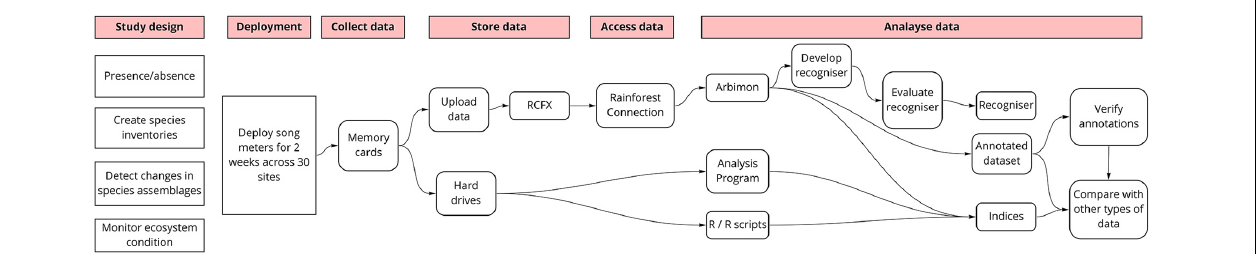
FIGURE 3 | Workflow for ecosystem condition analysis using ecoacoustics